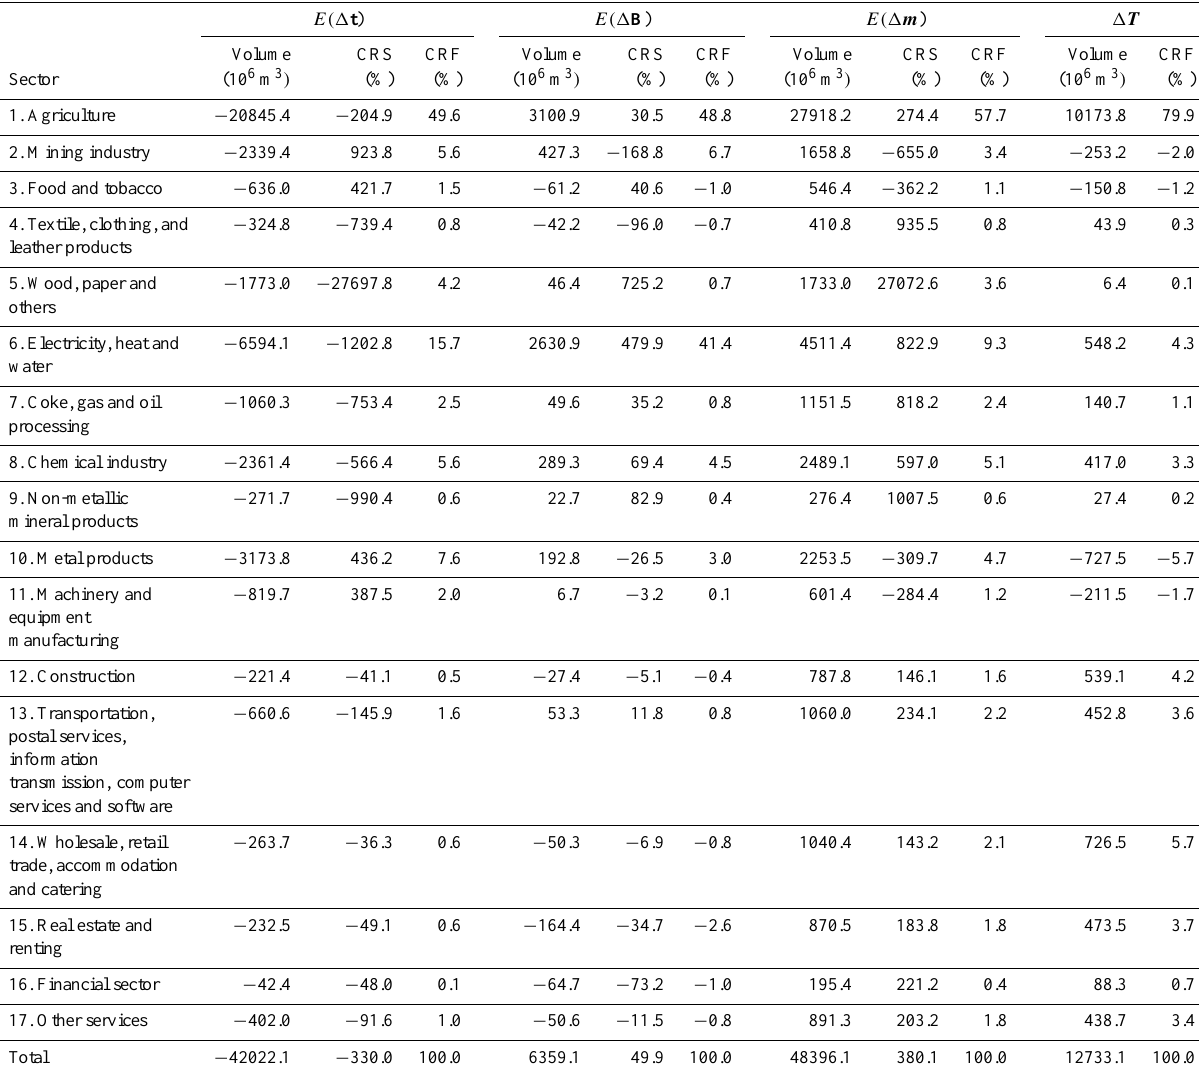
Table 1. Contribution of factors to the changes in total WF.